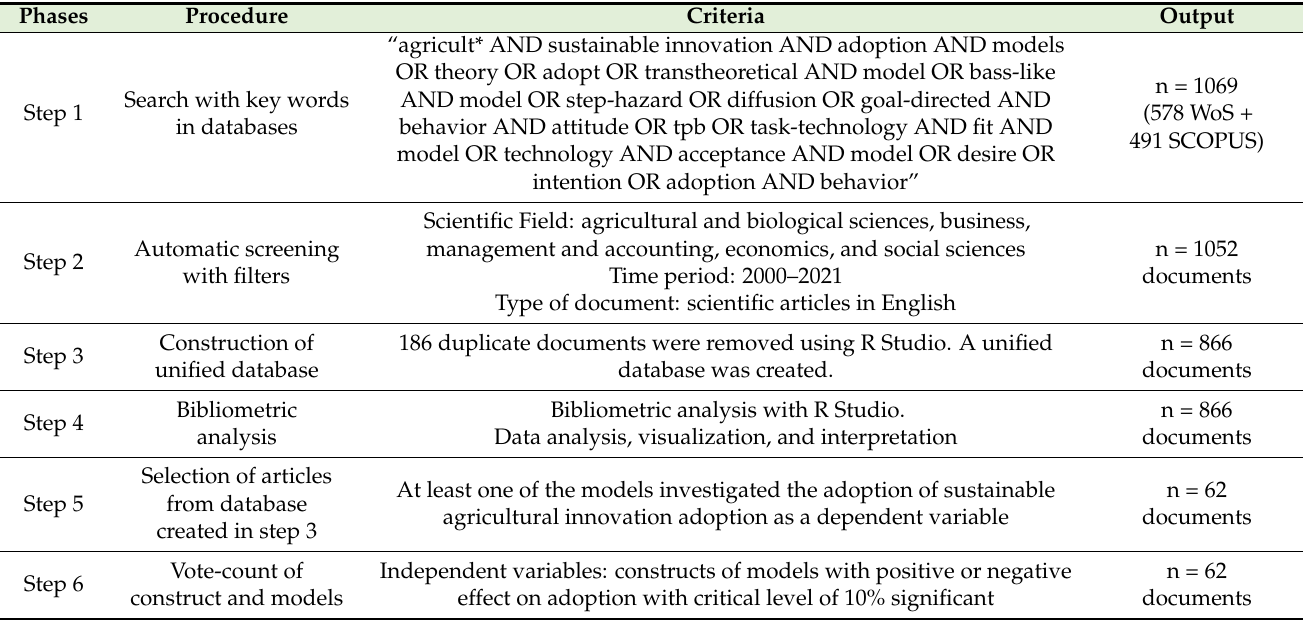
Figure 1. Publications per year (2000 – 2021). Note: The figure was generated using R Studio software (Bibliometrix tool) with the bibliographic coupling method [53], analyzing data from WoS and Scopus, with the author being the unit of analysis. Table 2. Description of the main steps to implement